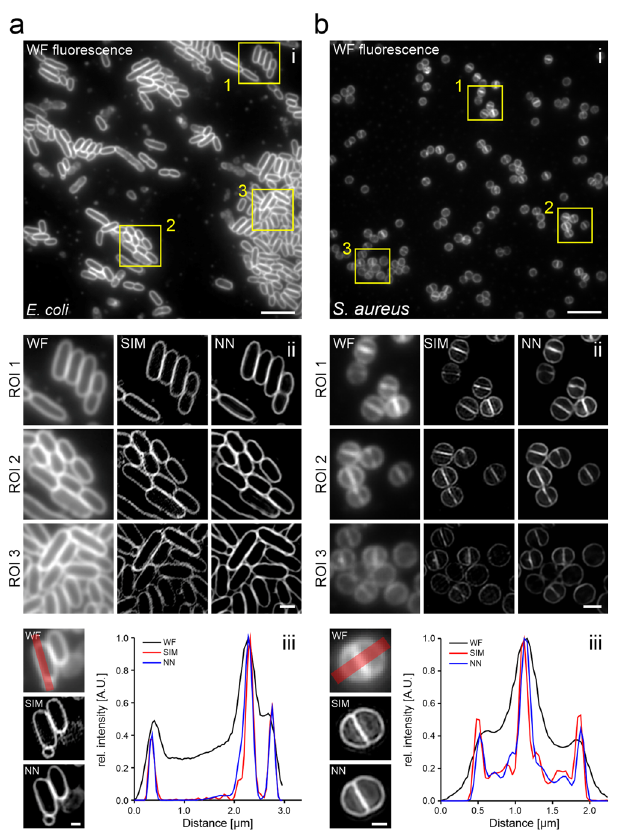
Fig. 6 Prediction of SIM images from wide fi eld fl uorescence images. Wide fi eld-to-SIM image transformation was performed with CARE for a live E. coli (FM5-95) and b S. aureus (Nile Red) cells. Shown are diffraction-limited wide fi eld images (i) and the magni fi ed regions (ii) indicated by yellow rectangles in (i). WF = wide fi eld; NN = neural network output. (iii) Line pro fi les correspond to the red lines in the WF images and show a good agreement between prediction and ground truth (bottom panel). Scale bars are 10 µ m (i), 1 µ m (ii) and 0.5 µ m